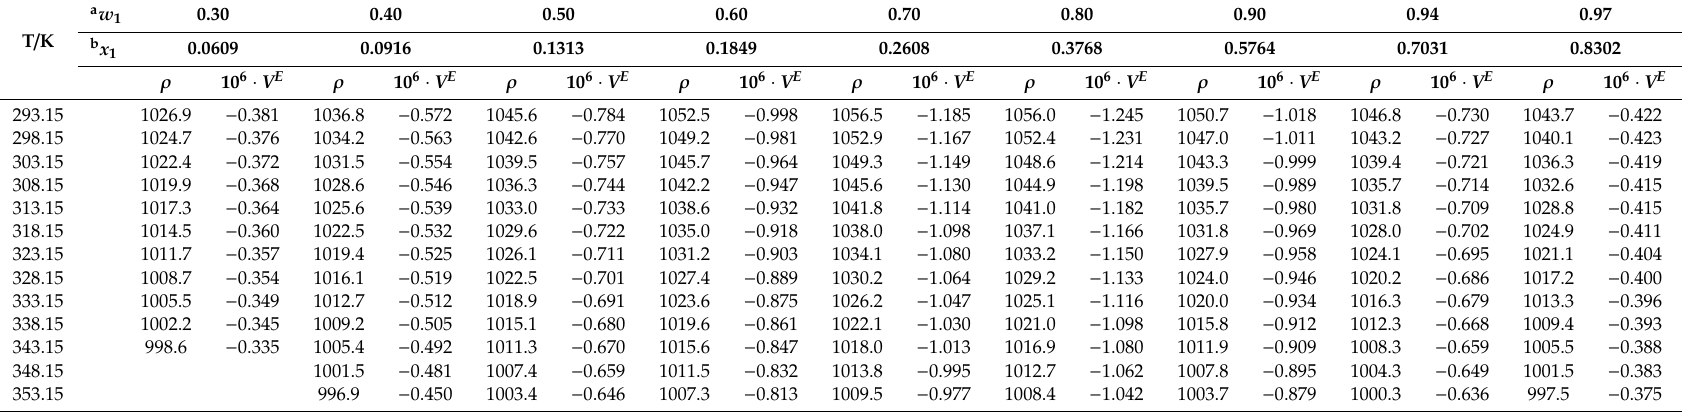
Table A1. Measured density ( ρ / kg · m − 3 ) and deduced excess molar volume ( V E / m 3 · mol − 1 ) of MDEA (1) + H 2 O (2) mixtures.